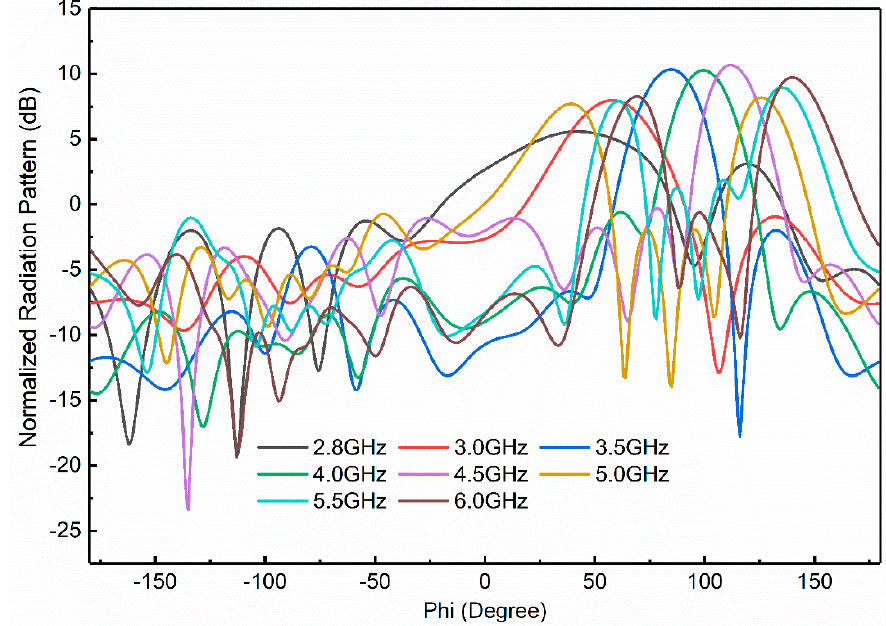
Figure 17. Normalized radiation pattern of the proposed developed frequency scanning fan beam array antenna with an integrated bandpass filter.